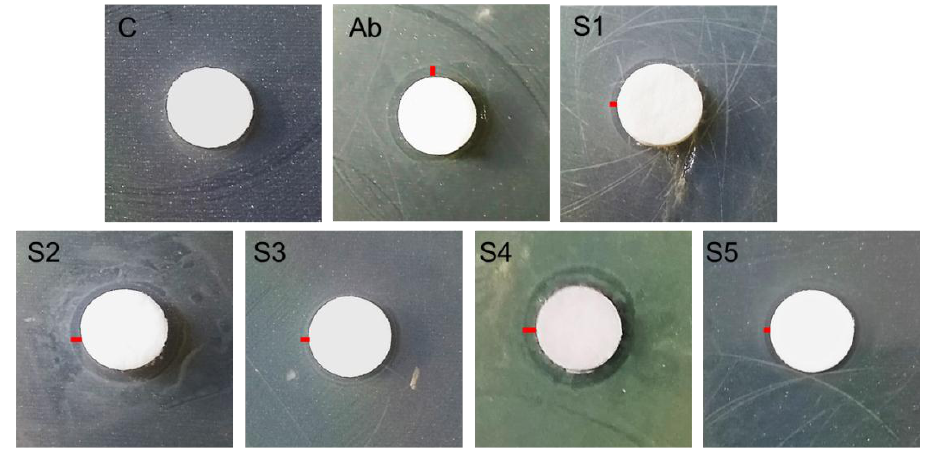
Figure 6. Pseudomonas aeruginosa zones of inhibition (ZOI) around silver nanoparticles (AgNPs) impregnated disks. The distance of the first colony from the disk/ZOI is demonstrated by arrow headed lines.